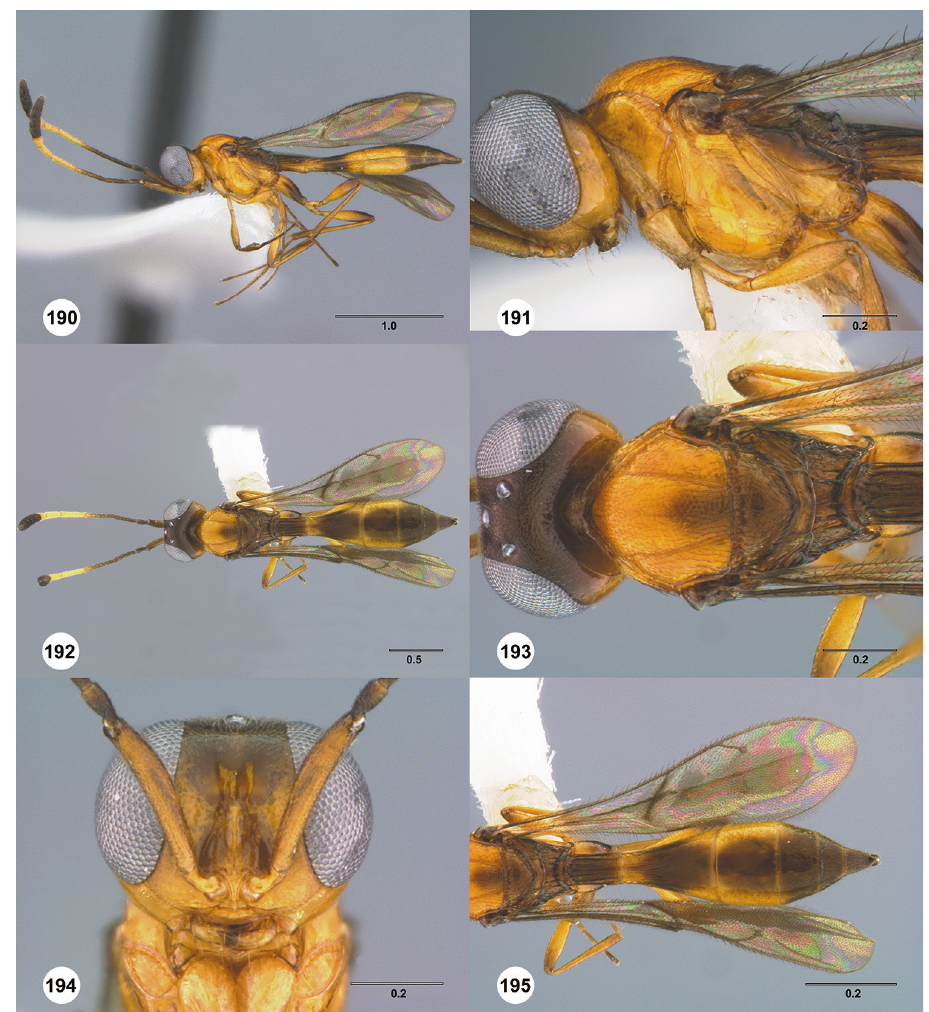
Figures 190–195. Calliscelio prolixus sp. n., female, holotype (OSUC 557587). 190 Lateral habi- tus 191 Head and mesosoma, lateral view 192 Dorsal habitus 193 Head and mesosoma, dorsal view 194 Head, anterior view 195 Metasoma, dorsal view. Scale bars in millimeters. behind outer orbit: smooth. Ocular setae: absent. A4 in female: distinctly longer than A3. A5 in female: longer than A3, distinctly longer than wide. Shape of female A6: distinctly longer than wide. Color of mesosoma in female: variably orange to pale brown. Sculpture of dorsal pronotal area: rugose. Sculpture of lateral pronotal area: smooth throughout. Sculp- ture of netrion: smooth. Notaulus: percurrent or nearly so. Sculpture of mesoscutum: coriaceous. Shape of mesoscutellum: semiellipsoidal. Foveolae of scutoscutellar sulcus between notauli: as large as those along margin of axilla. Sculpture of